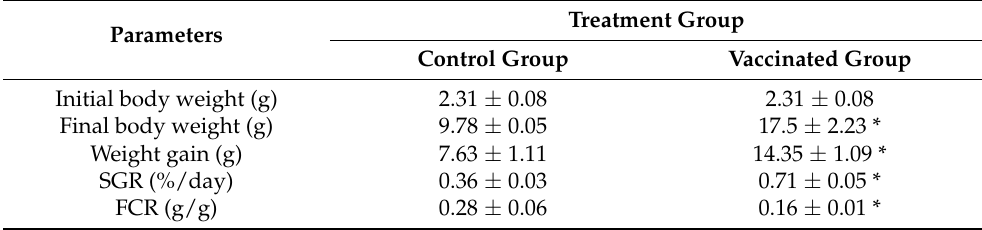
Figure 4. The fish growth performance based on total body weight and body length of the Asian seabass (mean ± SE, n = 25) during 6 weeks of vaccination trial period. Asterisks indicate a significant difference ( p < 0.05) from the control. Table 5. Growth performance parameters ( n = 25 per treatment) of Asian seabass fed with vaccinated feed for 6 weeks. Asterisks indicate a significant difference ( p < 0.05) from the control.